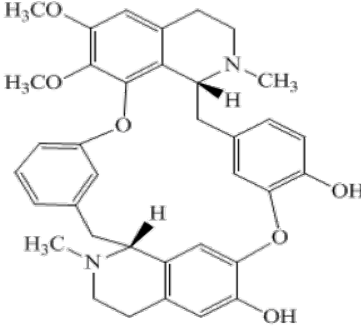
Figure 2. Structure of 10-hydroxy chondrofoline.